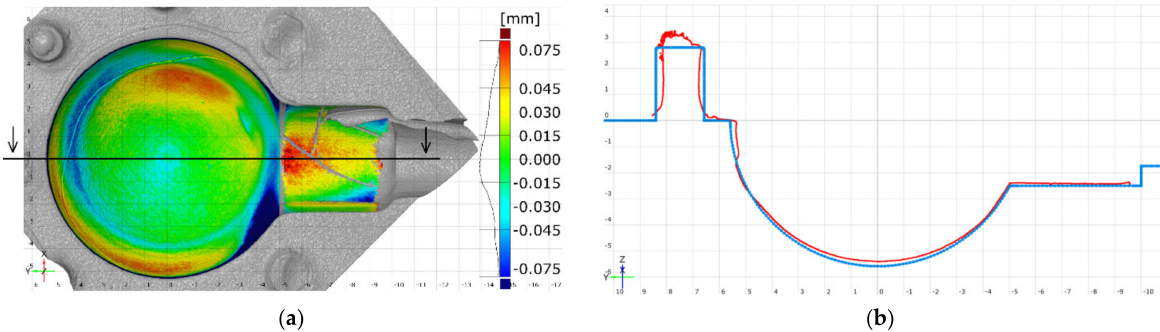
Figure 8. Printed element’s deviations: ( a ) from a fitted sphere and cylinder; ( b ) nominal (blue) and actual (red)